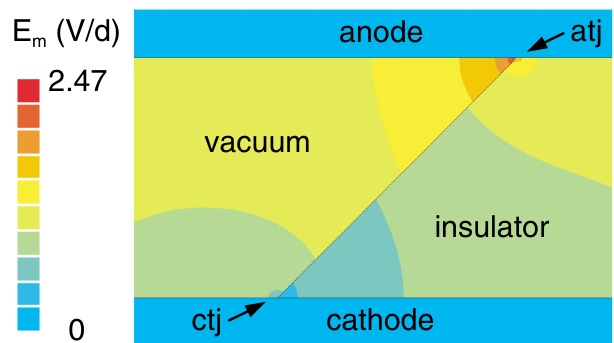
FIG. 2. (Color) The absolute value of the electric-field magni- as a function of position for the idealized 45 (cid:1) vacuum- tude E m insulator interface outlined in Fig. 1. The calculation assumes that the dielectric constant of the insulator " (cid:8) 2 : 55 . The anode triple junction (atj) is the point at which the vacuum, insulator, and anode regions meet; the cathode triple junction (ctj) is similarly defined. The color legend is a linear scale. The field is given in units of V=d , where V is the voltage across the insulator and d is the insulator thickness as defined by Fig. 1.